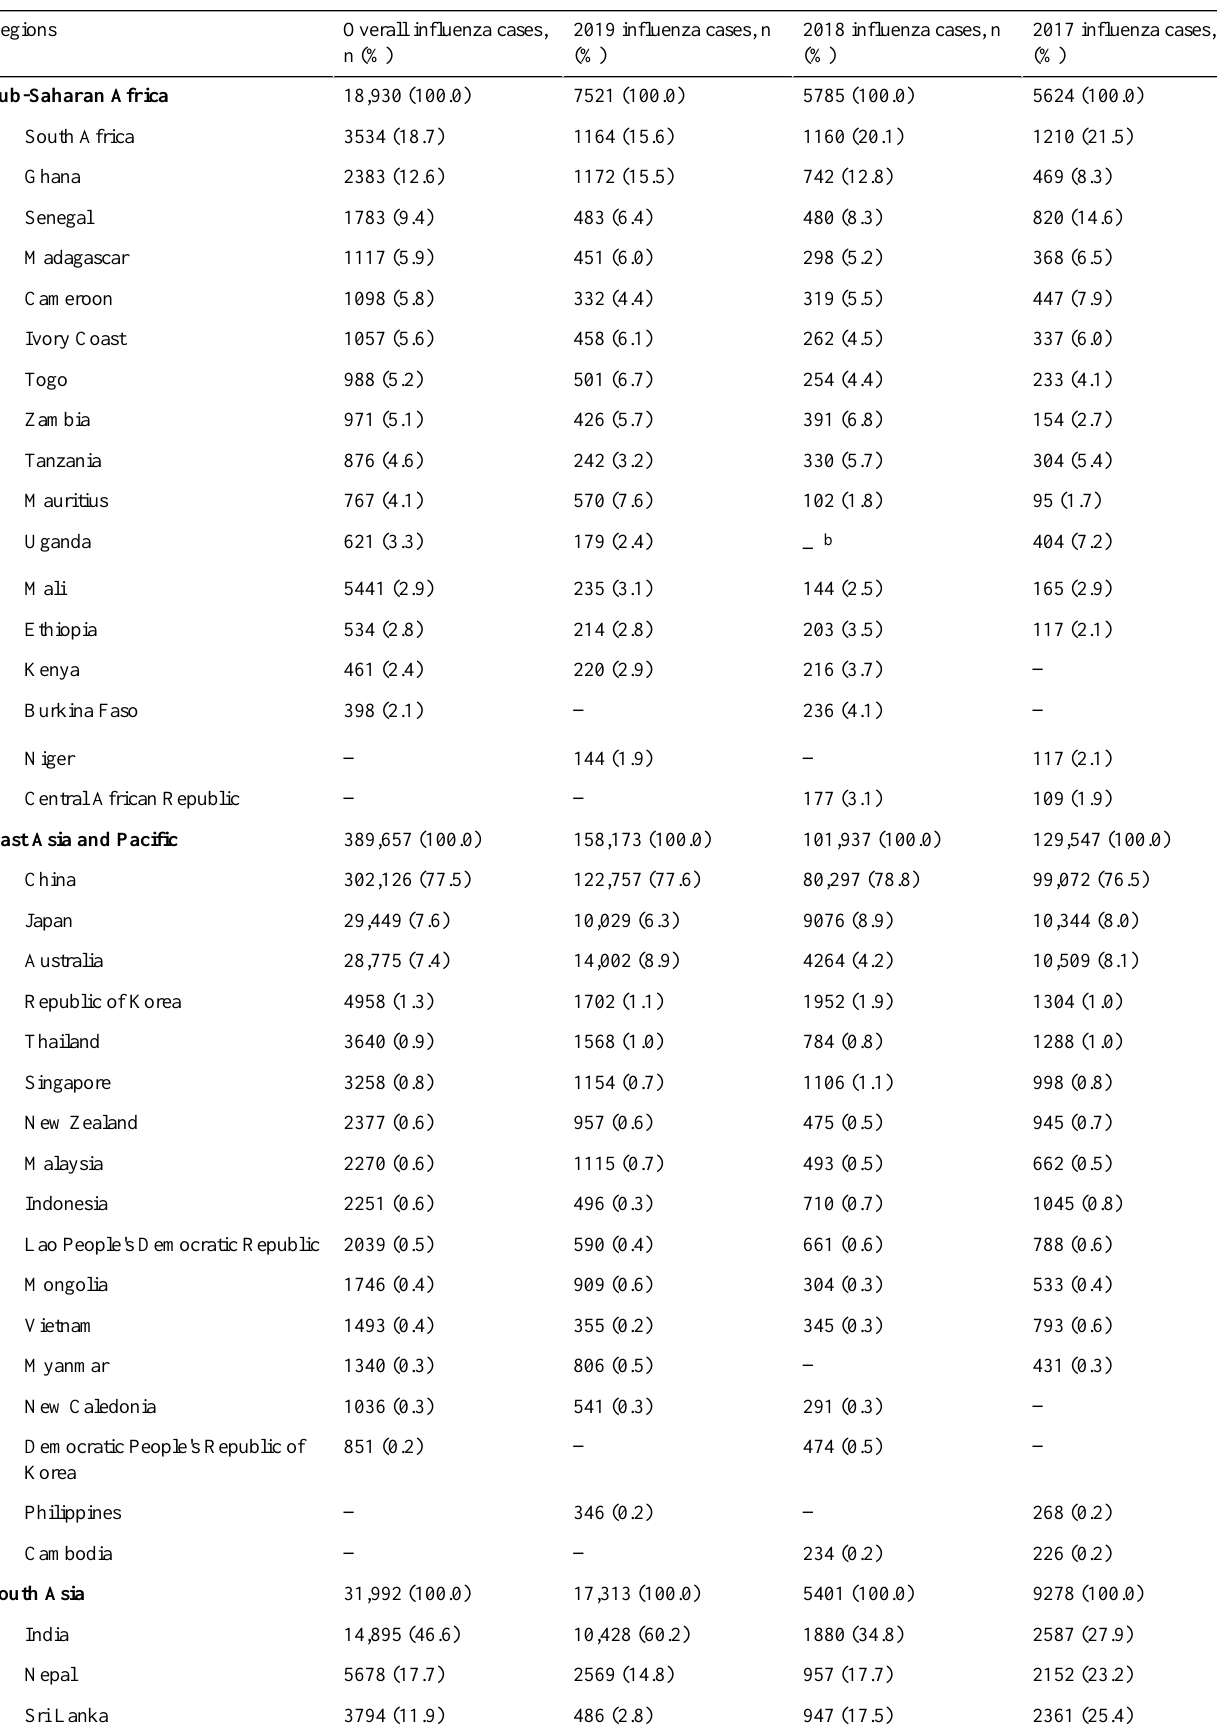
Table 1. Influenza cases for top 15 countries by World Bank region, overall and by year from January 1, 2017, to December 31 2019.